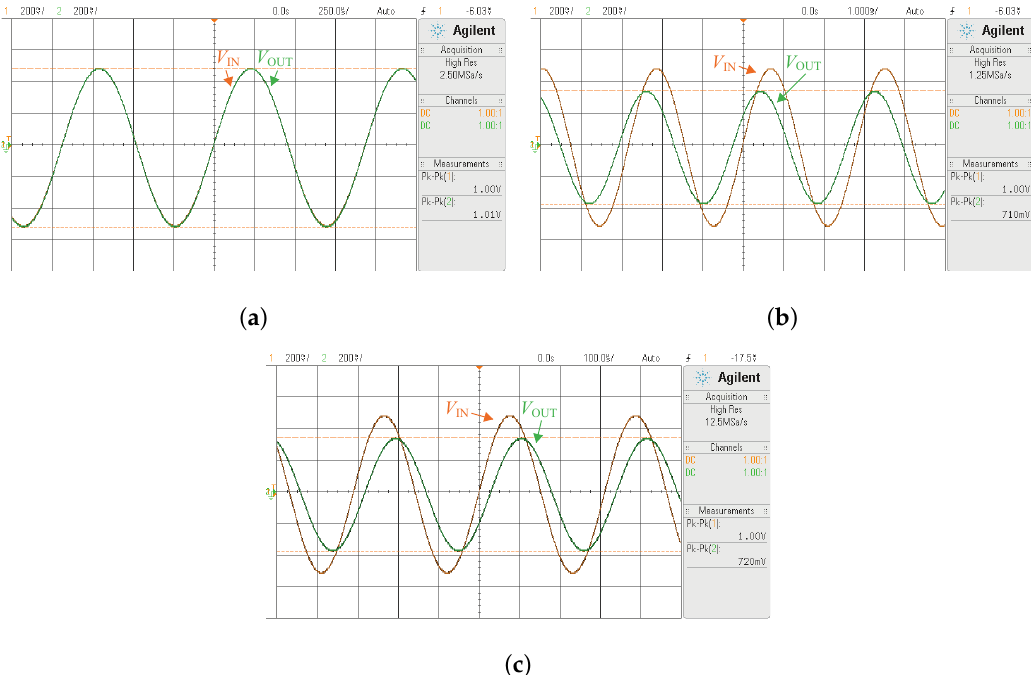
Figure 12. Input–output waveforms observed in oscilloscope for the proposed BPPLF ( α = 0.5 ) with an input frequency of ( a ) f 0 = 1.066 kHz, ( b ) f H,low = 353.9 Hz, and ( c ) f H,high = 3.214